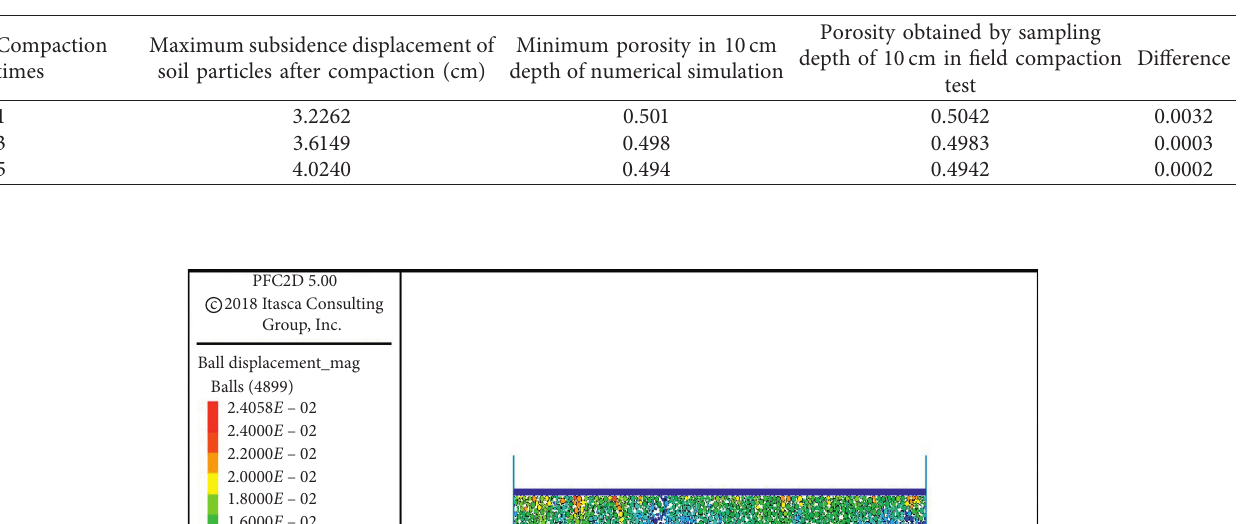
Table 6: Numerical simulation results for soil thickness of 30 cm.